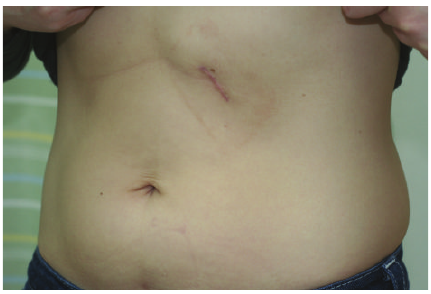
the right adrenal gland is solely achieved through retraction of the liver, which can be avoided with a posterior